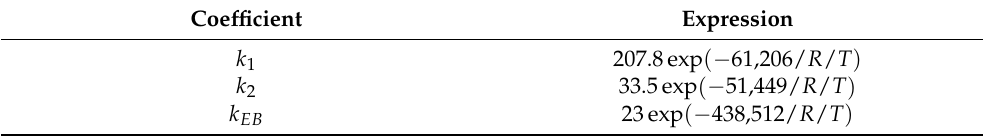
Table 1. Kinetic parameters for